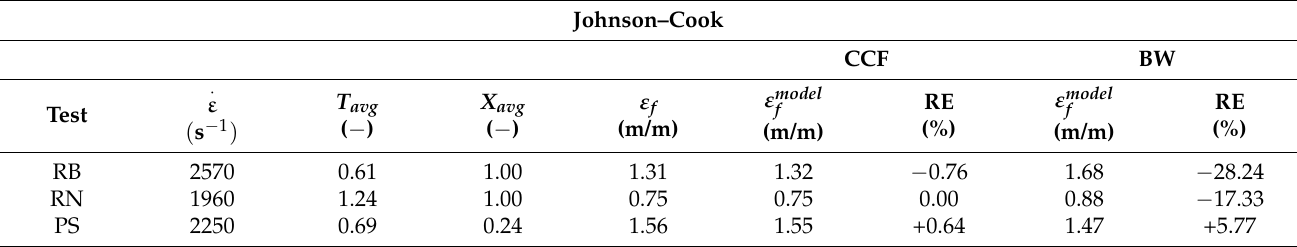
Figure 9. Comparison between the deformed shape observed in the real experiments and the shapes predicted by FE analyses. Color contours represent the equivalent plastic strain distribution computed with the ZA model. Table 5. Numerical results, JC model: strain rate ( ε ) , average T and X values; experimental strain ) and relative error (RE) as predicted by the CCF and BW at fracture ( ε f ), strain at fracture ( ε model f damage